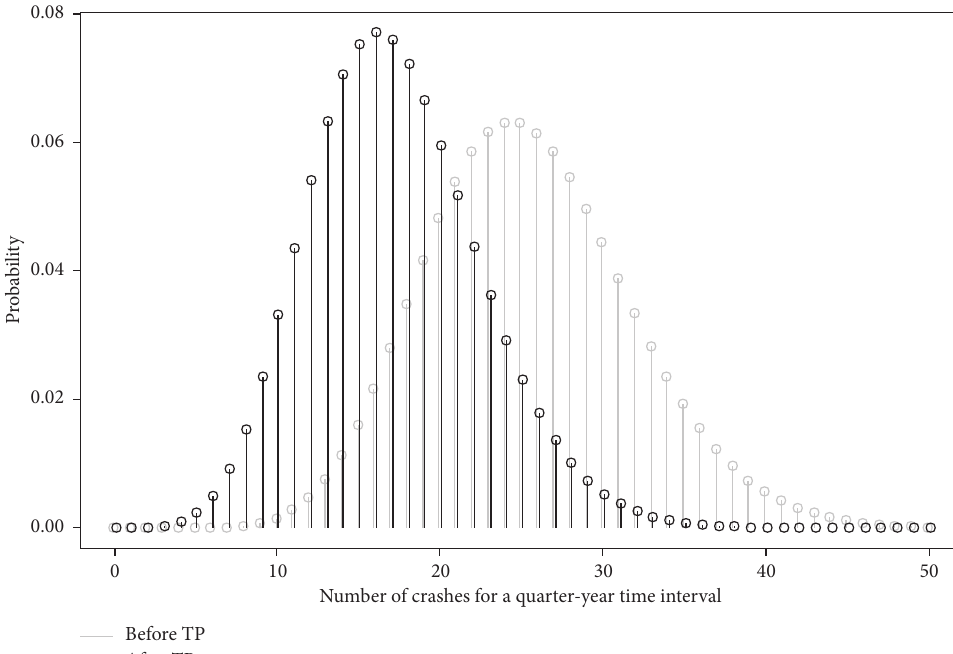
Figure 6: Probability mass functions of NB distributions before and after installation of